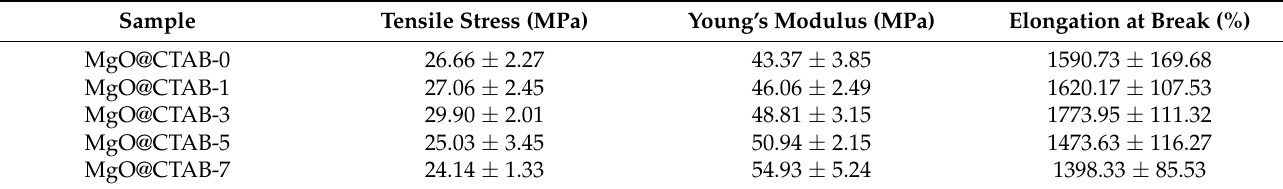
Figure 8. Tensile stress versus strain of PBAT nanocomposites. Table 3. Tensile properties of PBAT nanocomposites.